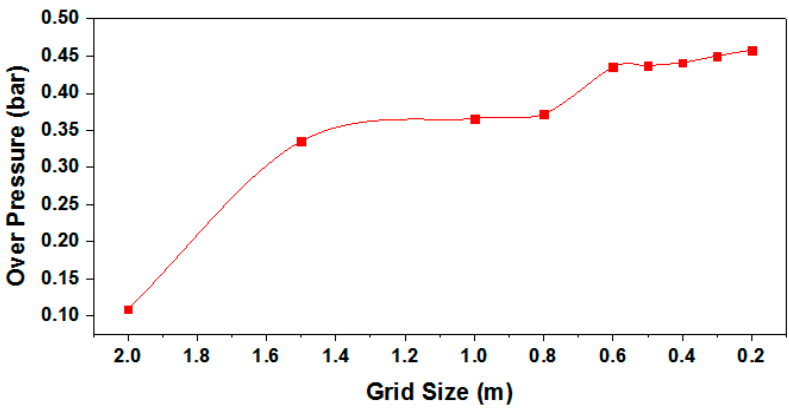
Figure 7. Vapour Cloud Explosion (VCE) mesh sensitivity study.